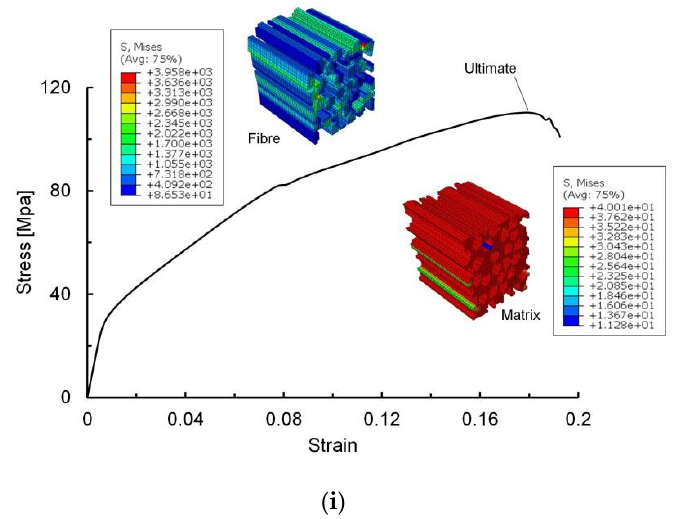
Figure 7. Equivalent stress-strain curves and von Mises stress plots of micro-scale RVE model of yarn in WR under ( a ) X-tension, ( b ) X-compression, ( c ) Y-tension, ( d ) Y-compression, ( e ) Z-tension, ( f ) Z-compression, ( g ) XY-shear, ( h ) XZ-shear, and ( i ) YZ-shear.